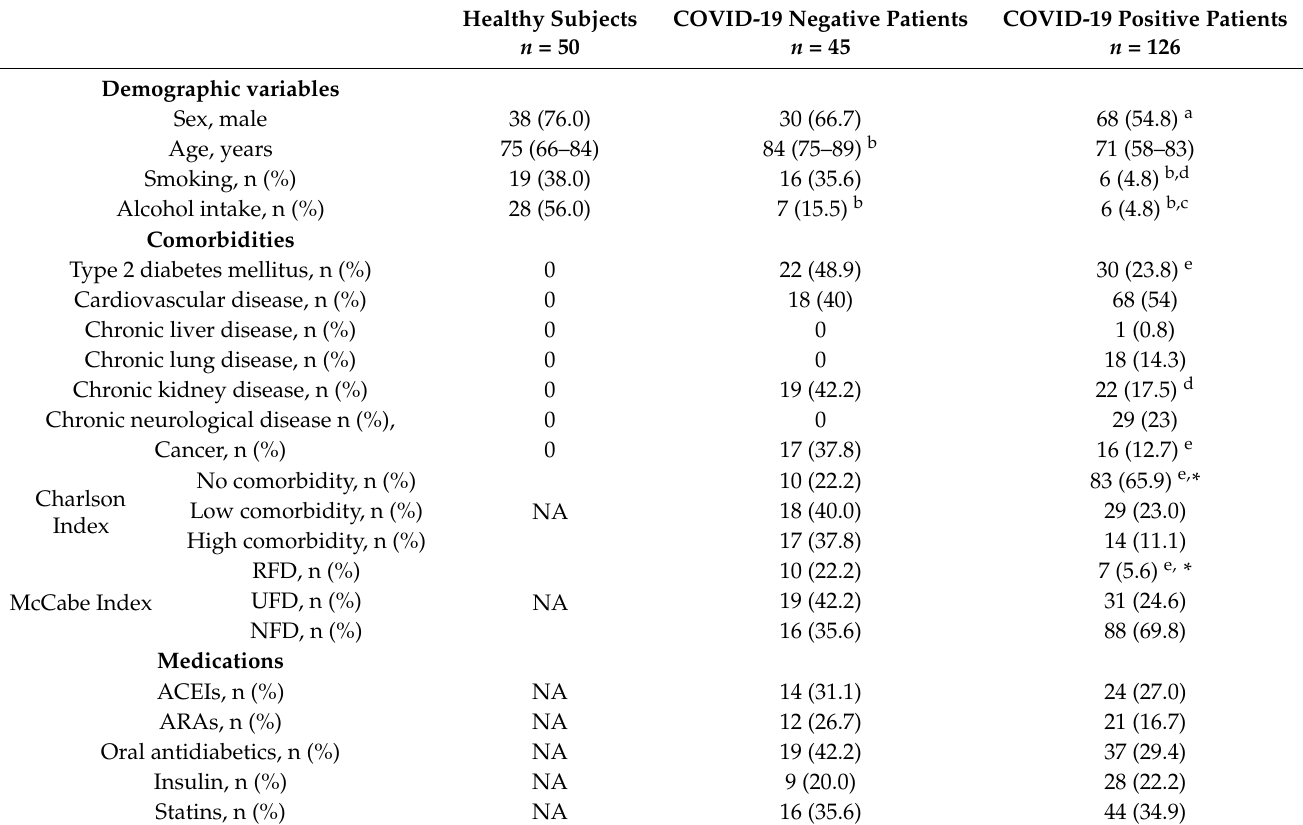
Table 1. Demographic and clinical characteristics of the patients and the healthy subjects. Healthy Subjects COVID-19 Negative Patients COVID-19 Positive Patients n = 50 n = 45 n =